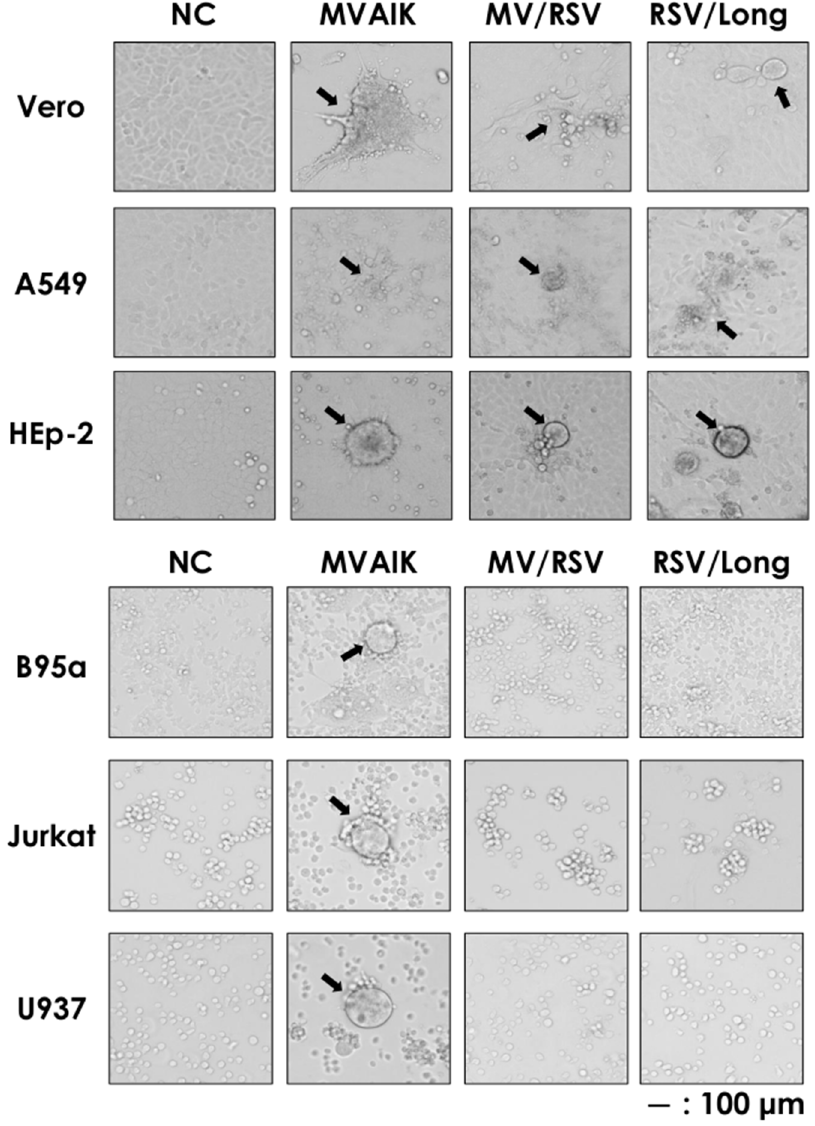
Figure 5. Appearance of CPEs in Vero, A 549, HEp-2, B95a, Jurkat, and U937 cells infected with MVAIK, MV/RSV, and RSV/Long. Vero, A 549, HEp-2, B95a, Jurkat, and U937 cells were infected with MVAIK, MV/RSV, and RSV. The cells were fixed and CPE was observed. Arrows indicate the appearance of cell fusion. Scale bar of 100 μ m is shown.